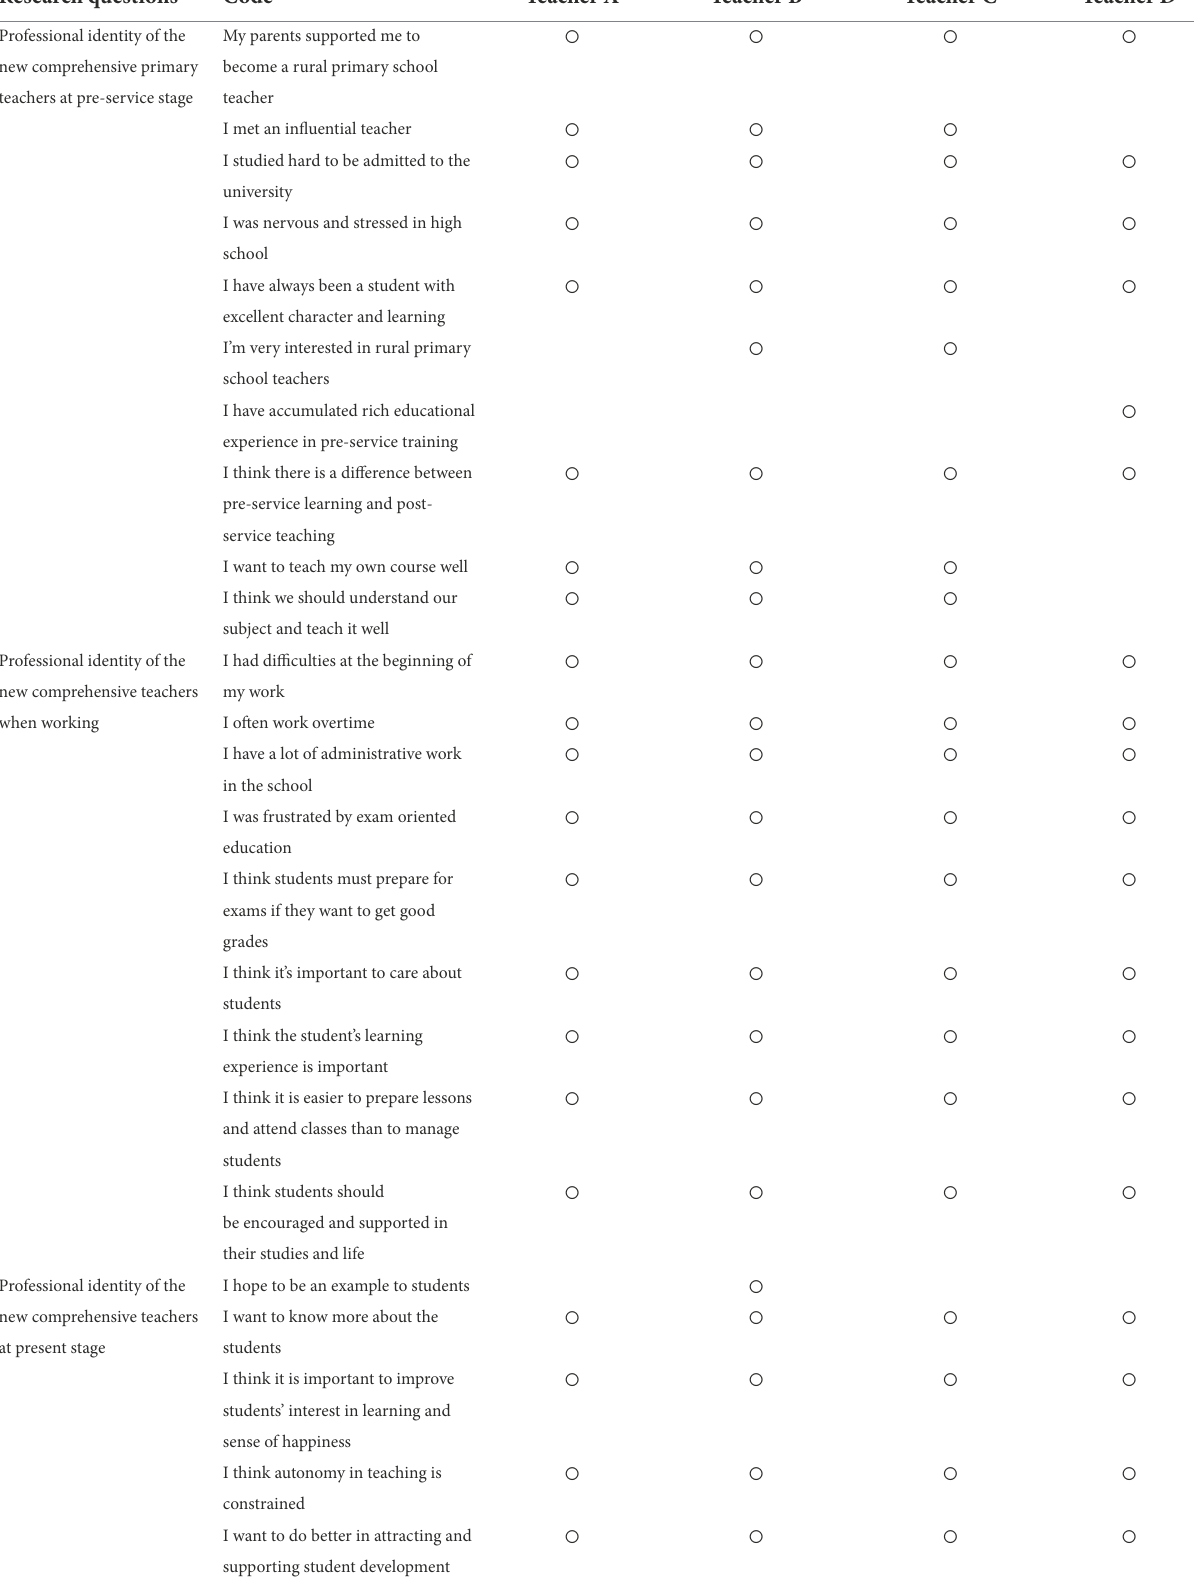
TABLE 2 The identity of the new comprehensive teachers in three different stages. Research